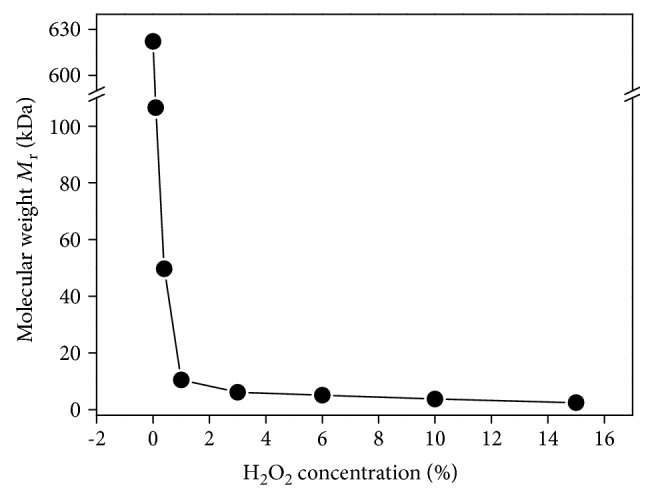
Relationship between H2O2 concentration and molecular weight of degraded GLPs.